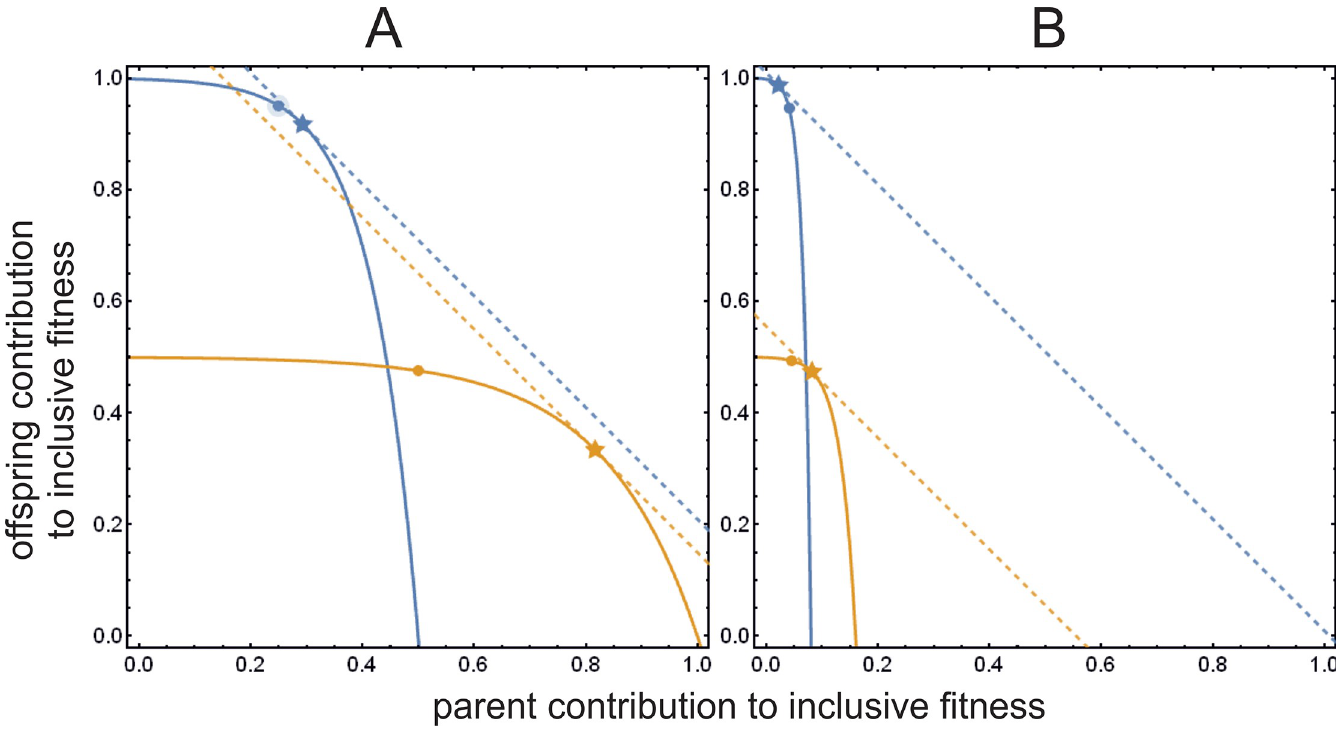
Fig 1. Inclusive fitness functions and optima without signalling cost. (A) G = ½ ; (B) G = 0.08 (as in [7]). Inclusive fitness functions parameterized by z are shown as yellow curve for parent’s (function u according to Eq 2 without signal cost f ( x )) and (blue curve for offspring (function v according to Eq 1 without signal cost f ( x )). The x coordinate value of parent’s curve is the parent’s own fitness contribution g ( c , z ), the y coordinate value is the fitness contribution the offspring ( γ h ( c , z )); similarly, the x value of the offspring’s curve is the parent’s contribution ( ψ g ( z )), the y value is the offspring’s own fitness h ( c , z ). The actual inclusive fitness value is the sum of the appropriate coordinate values, both for parent and offspring. Parameters are Z = 2, γ = 1/2, ψ = ½ , U = 1, c = 3. Yellow and blue stars indicate parent’s and offspring’s optima, respectively. Dashed lines are the calculated derivative tangents that touch optima at 45˚, indicating maximum fitness. The optimum z value for parent and offspring are not identical: the yellow dot indicates what the parent’s fitness is at the offspring’s optimum z ; blue dot is the offspring’s fitness in case of parent’s optimum z .